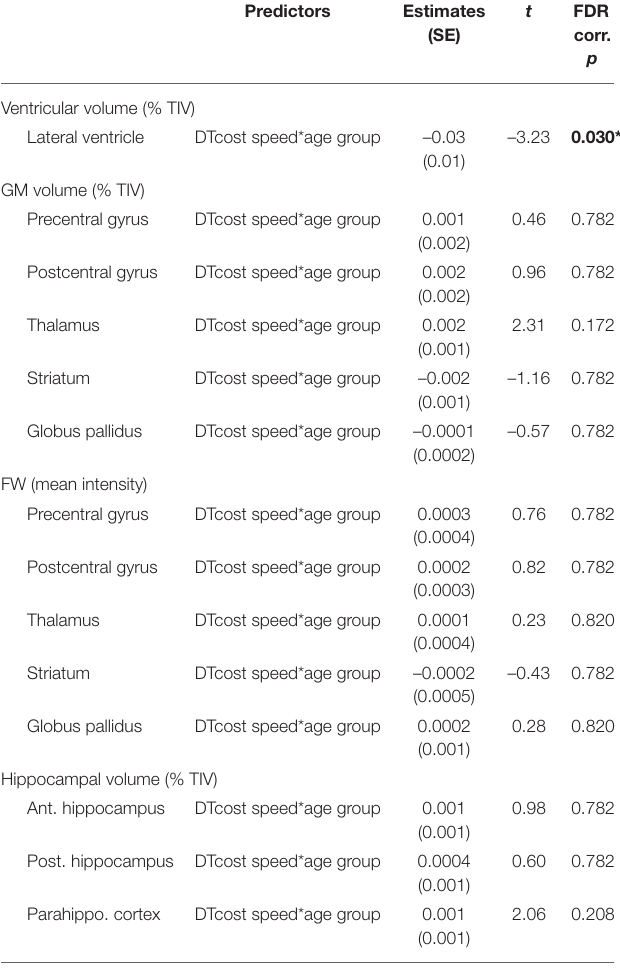
TABLE 6 | Regions of age difference in the correlation of cortical thickness with the DTcost of step time variability.